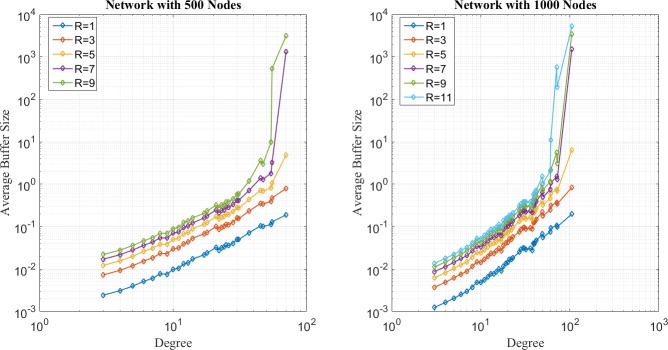
Relationship between average buffer size and node degree for SP on networks with 500 nodes (left figure) and 1000 nodes (right figure).